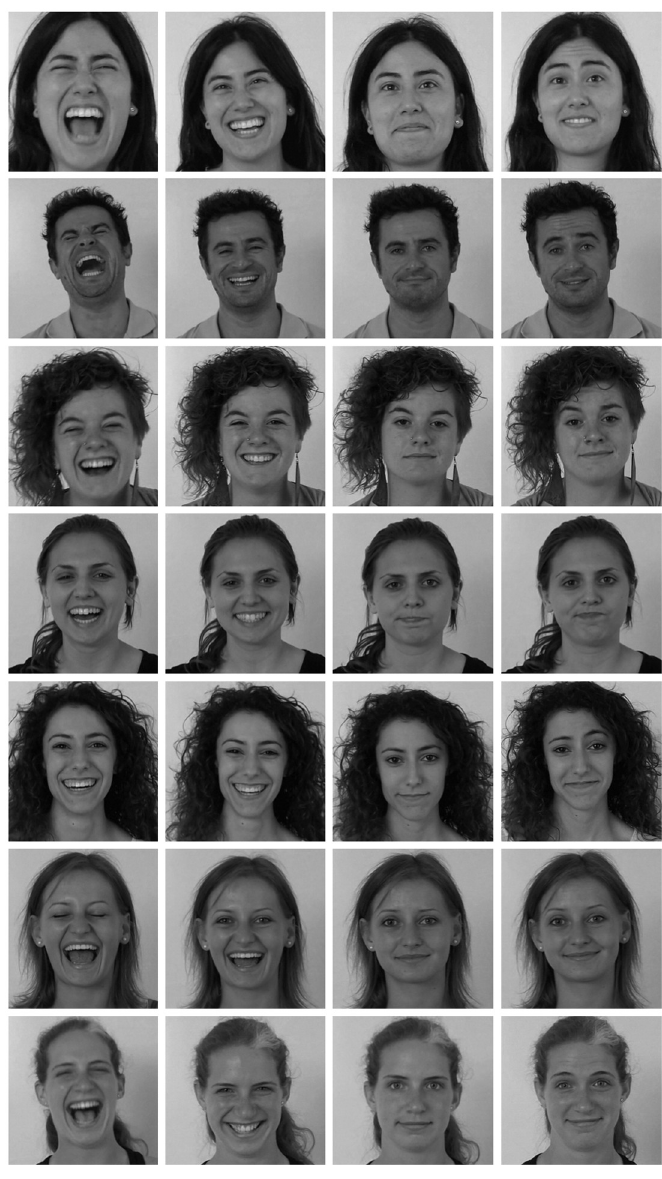
Fig 5. Multiple subjects with different laughter and smiling types of the MASEPESmile data